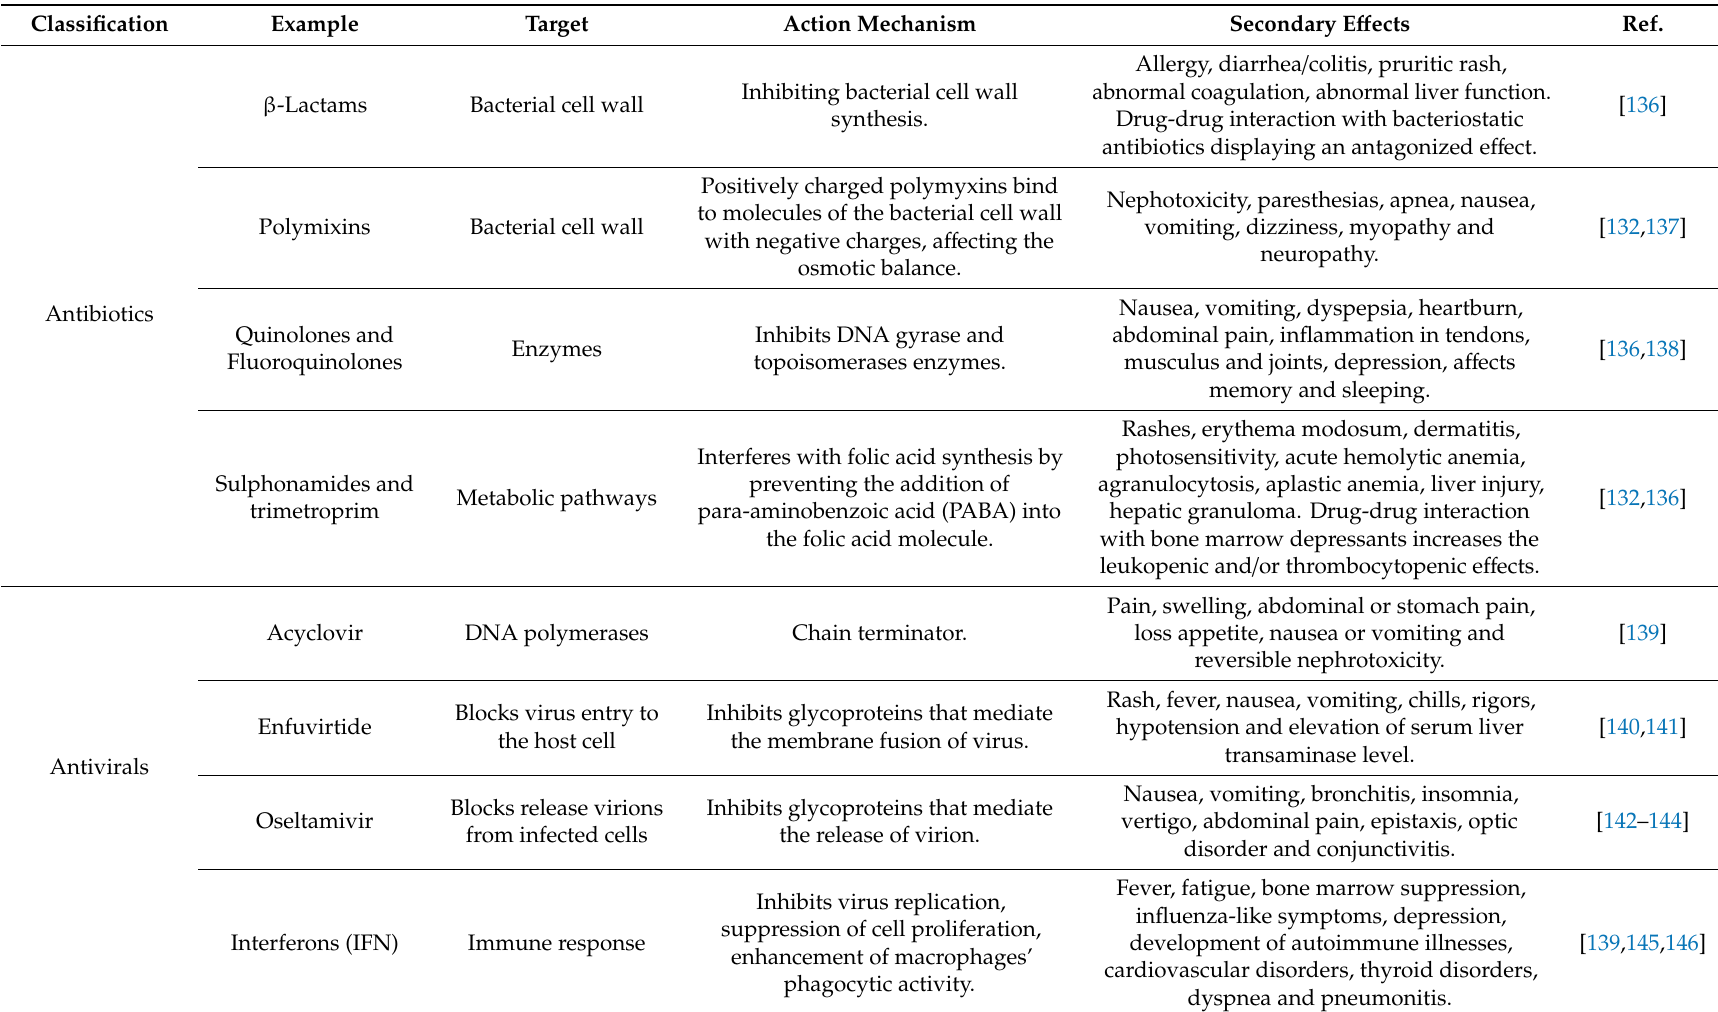
Table 1. Therapeutic principles to treat intracellular